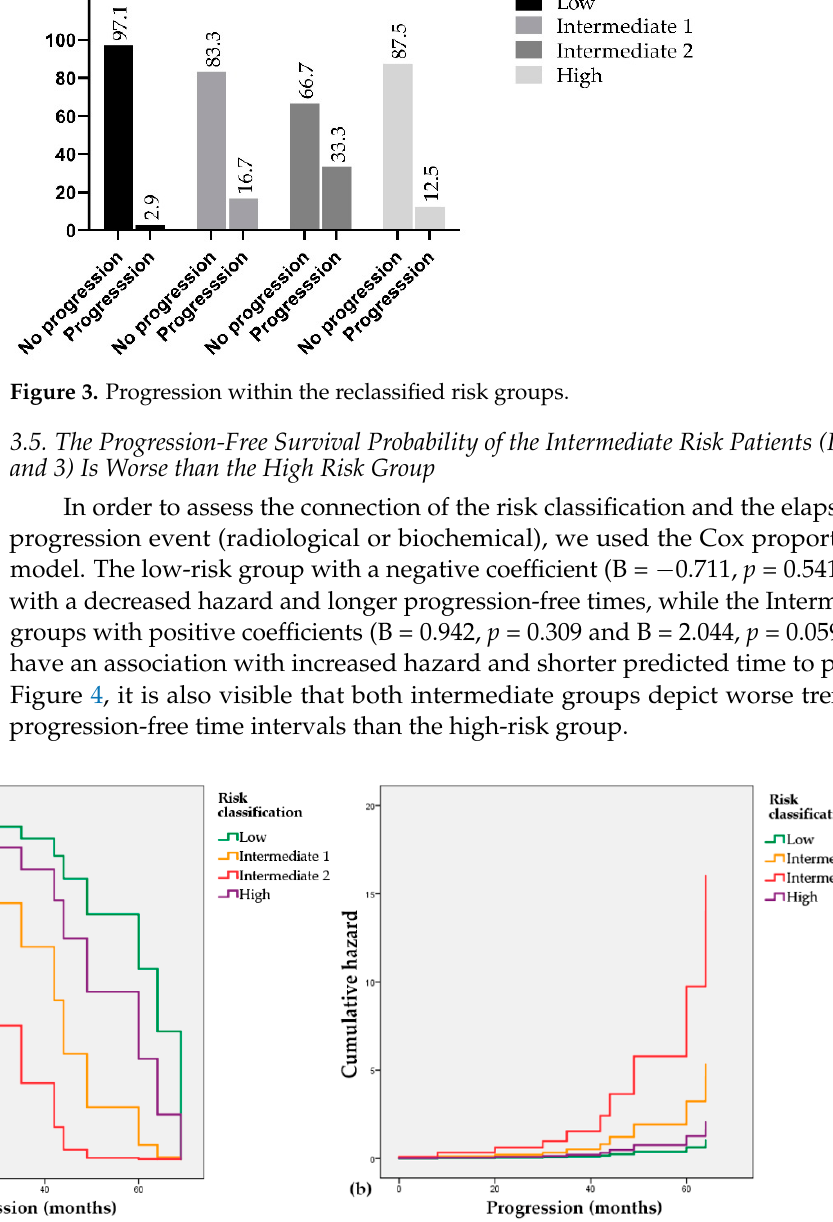
Figure 5. Results of the machine learning approach. ( a ) Receiver operating characteristic (ROC) curve of the original clas- sification-based model; ( b ) ROC curve of the model based on the International Society of Urological Pathology (ISUP) reclassification. In both of the models, at the point (0.6, 0.9), we correctly label about 90% of the cases, with a 60% false positive rate. In the middle, around (0.3, 0.8), we correctly label about 80% of the cases, with a 30% false positive rate. 4. Discussion According our calculations, 12.3% of the variance in progression is explained by the risk classification. This result raises the necessity to acknowledge other factors which are not represented in our study, such as individual biological variance or the general social and health status regarding patients. Classification of the analyzed individuals, in 2012, was guided by the pathological report, clinical status, laboratory parameters, computed tomography (CT) and scintigraphy investigations. The histopathological examinations